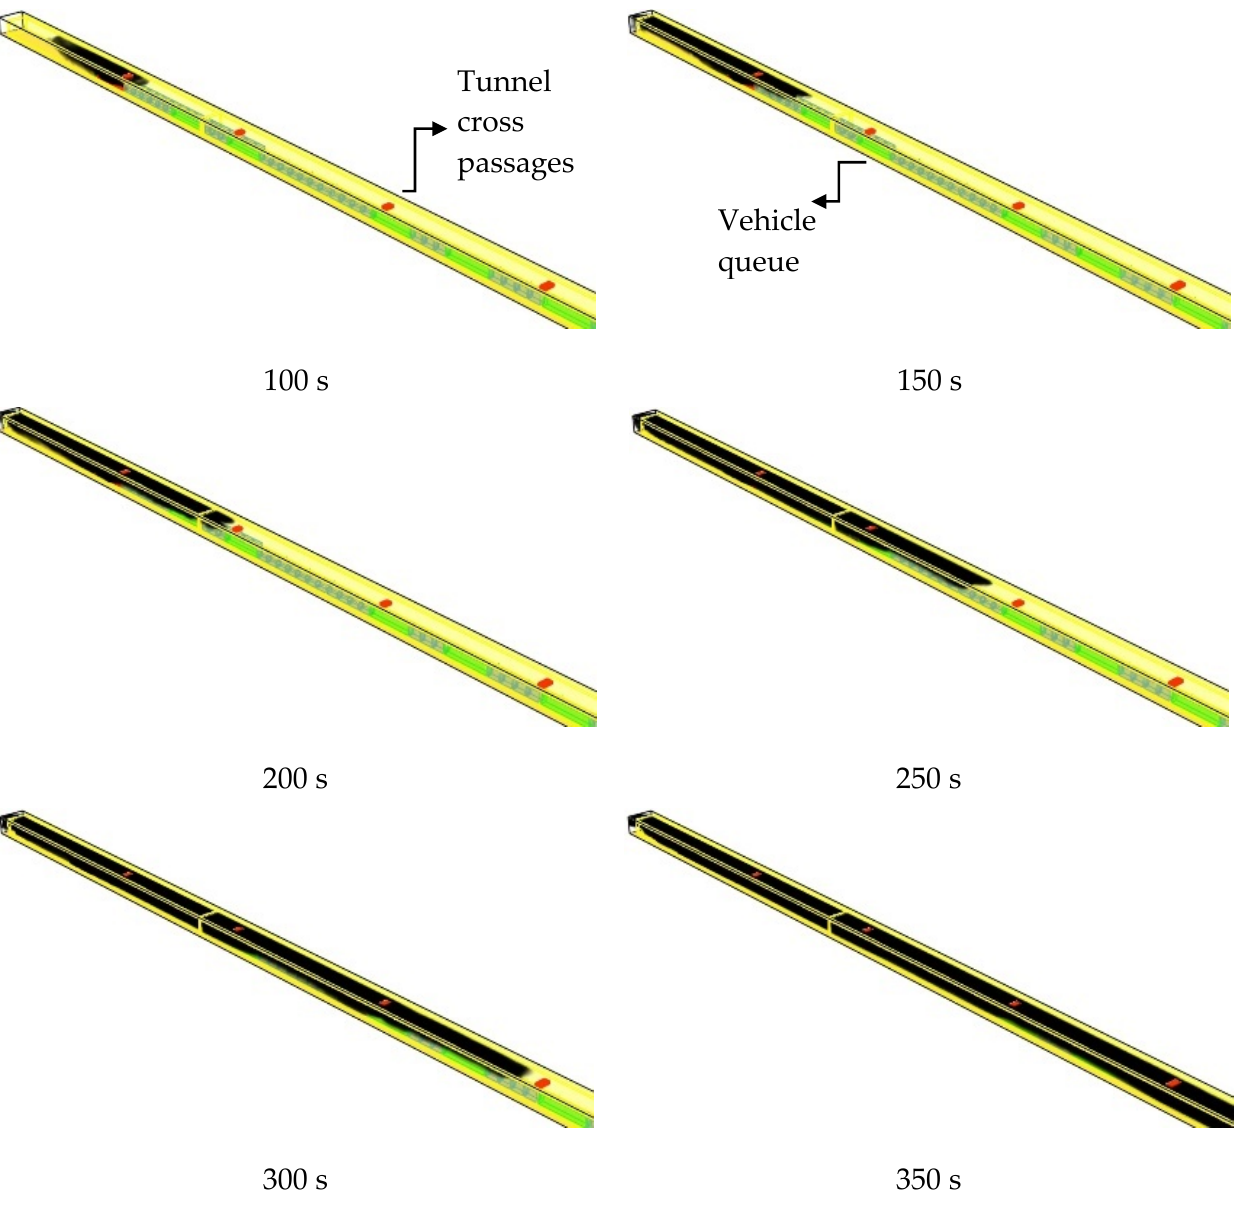
Figure 8. Three-dimensional simulation of fire spread for a fire scenario with 158 MW fire size, 3.5 m/s ventilation velocity, and stoppage traffic.